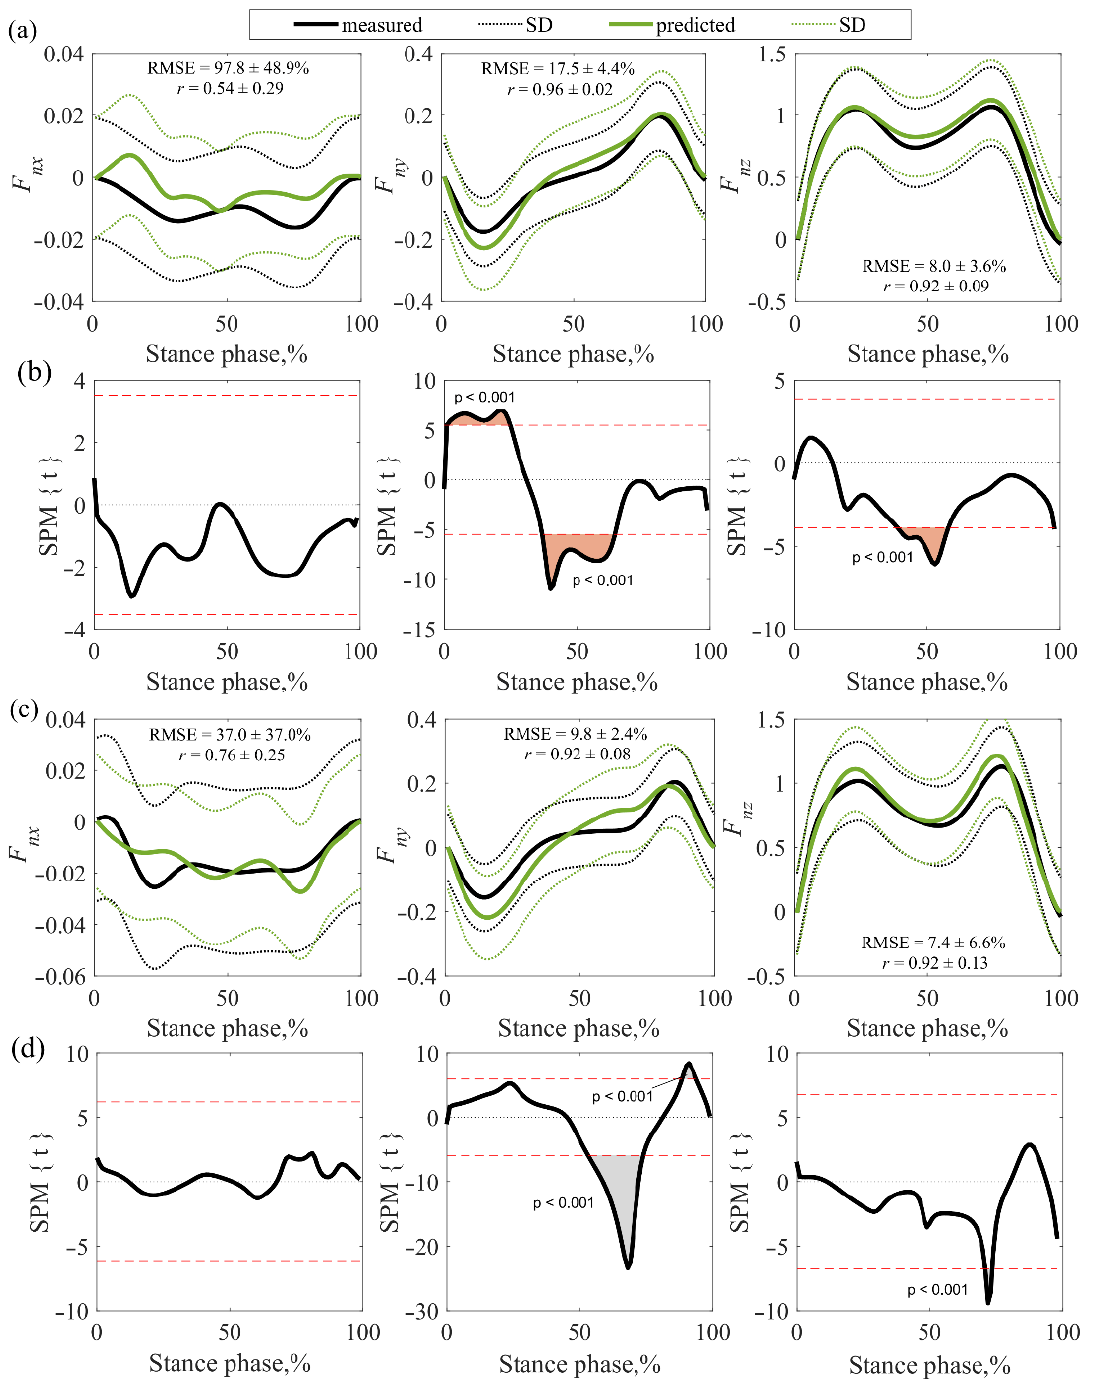
Figure 7. Results of the comparison of the measured and model predicted GRFs for the right leg: ( a ) averaged force curves for the HCH; ( b ) mismatch of HCH curves; ( c ) averaged force curves for the CP subjects; ( d ) mismatch of CP curves.